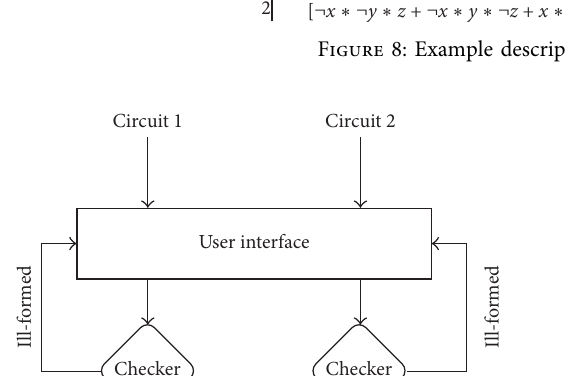
Figure 8: Example description in the output language.